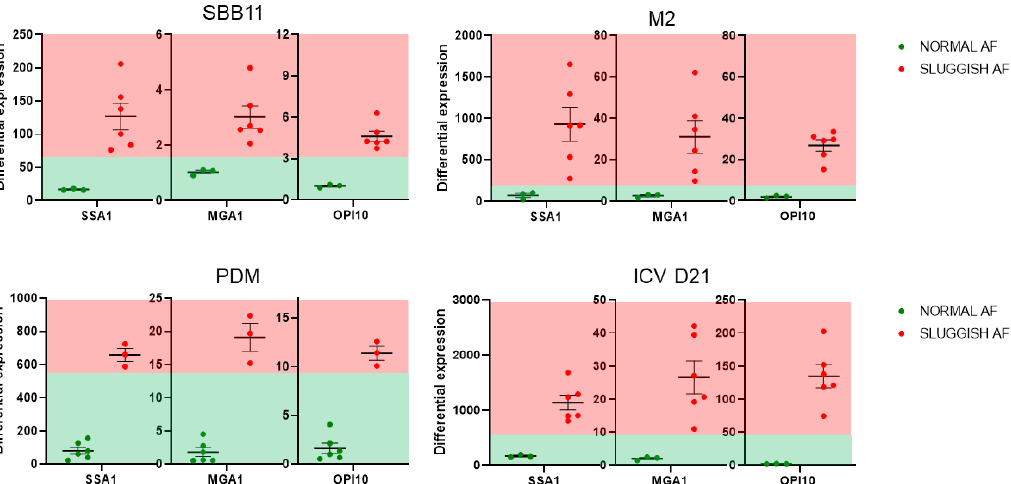
Figure 5. Safe (light green) and danger (pink) zones defined by differential expression of biomarker genes (SSA1, MGA1 and OPI10) for the four strains (SBB11, PDM, M2 and ICV D21). Red dots represent gene expression in sluggish fermentations until 9 h after heat shock onset. Green dots represent gene expression in normal fermentations until 9 h after heat shock onset and control treatments.